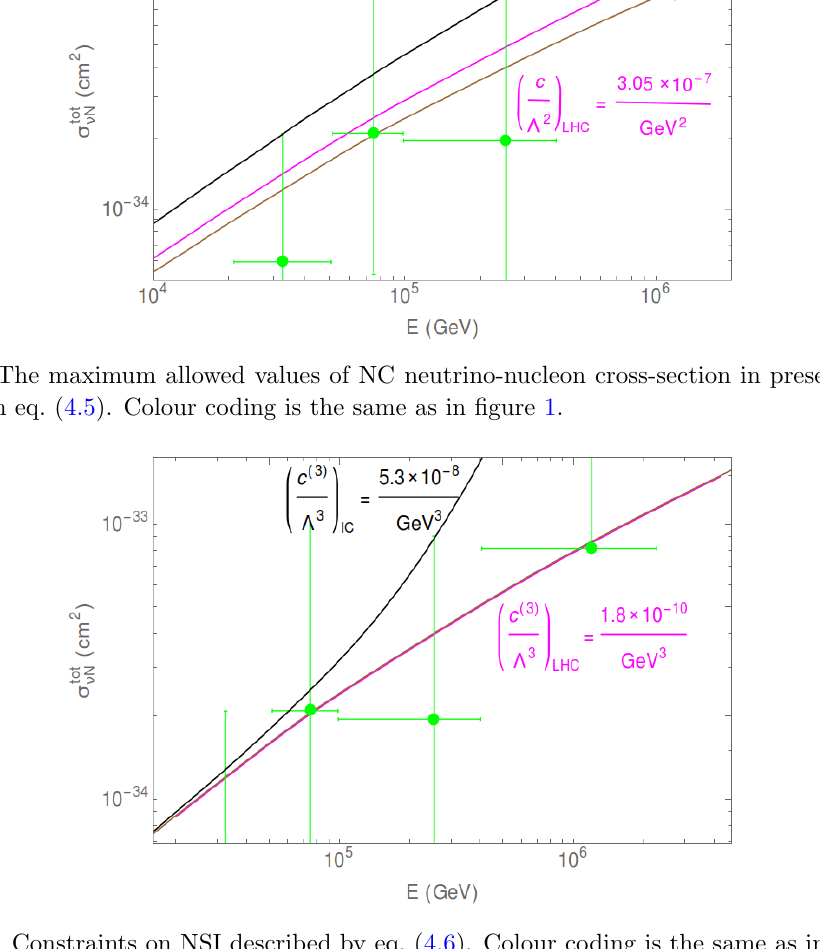
Figure 6 . Constraints on NSI described by eq. (4.6). Colour coding is the same as in (cid:12)gure